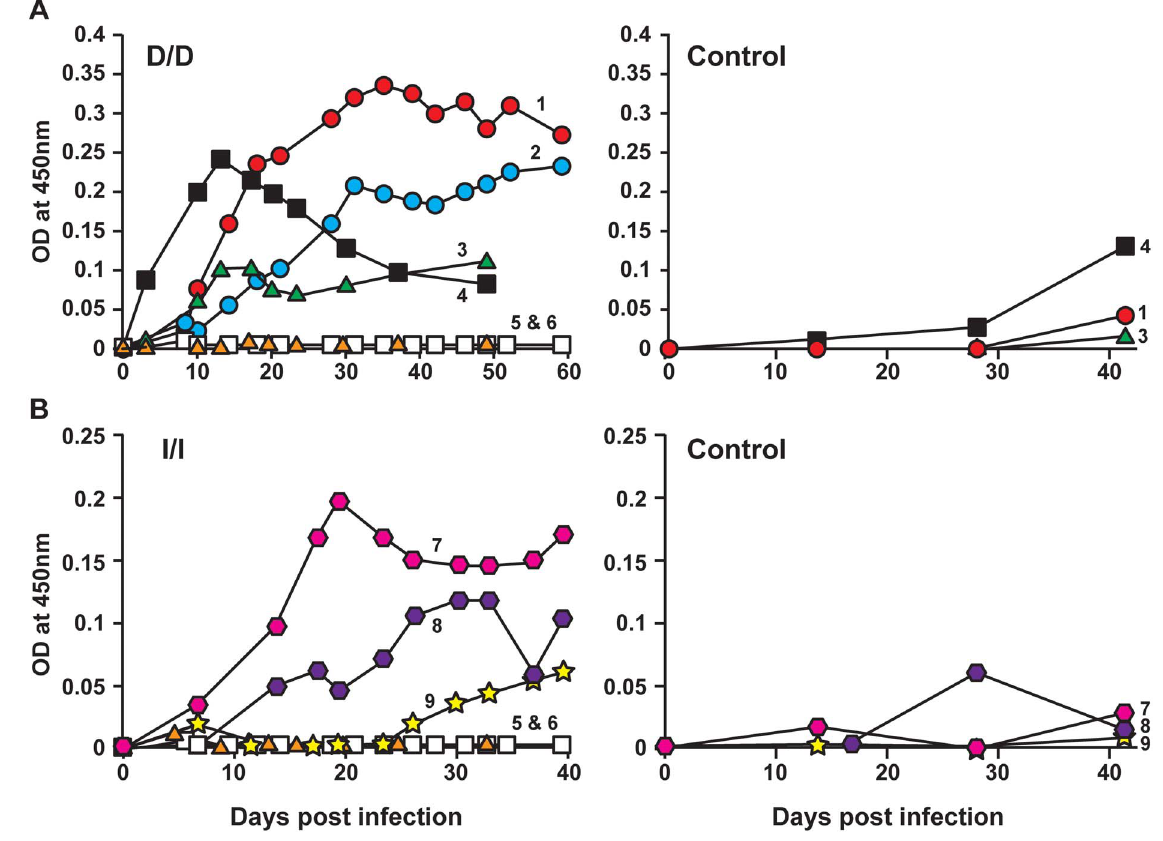
Figure 2. Antibody response of deer i.v. infected with E.chaffeensis culture in DH82 cells or in ISE6 cells (left panels of A and B, respectively). D/D represents both infection inoculum and E. chaffeensis antigens used for ELISA are from DH82 cultures, while I/I refers to both the infection inoculum and the ELISA antigens are obtained from ISE6 cultures. Deer 1–4 and 7–9 are infected animals and deer # s 5 and 6 are uninfected controls. The animals were also assessed for the IgG response against uninfected DH82 and ISE6 host cell antigens (right panels of A and B, respectively).